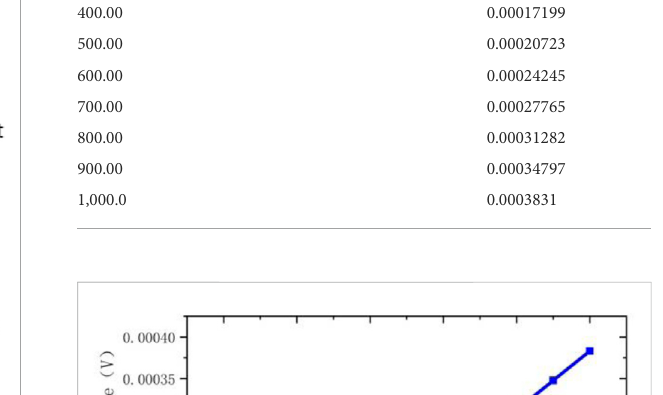
FIGURE 14 Piezoresistive patch Schematic.